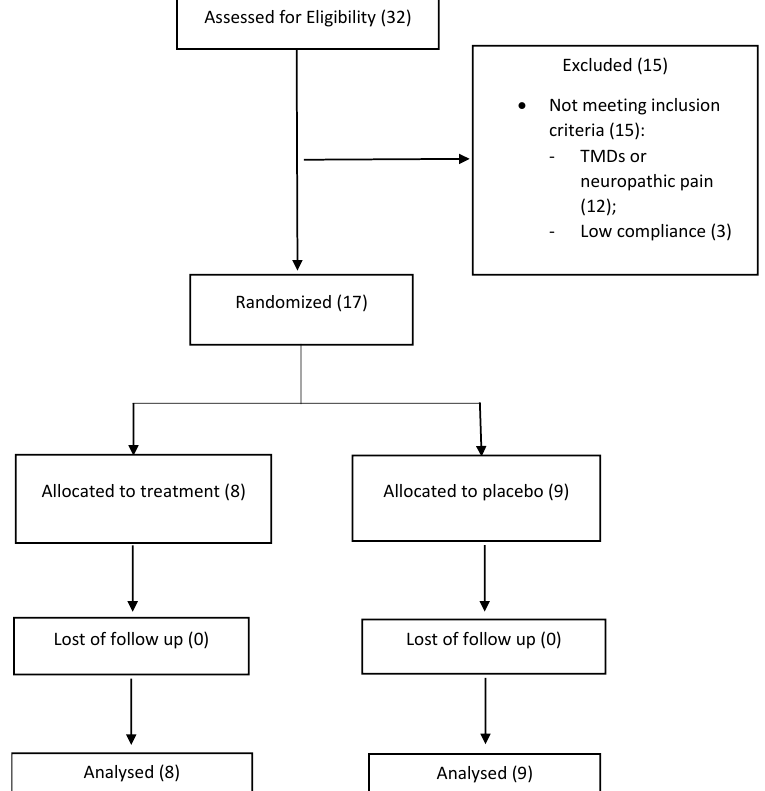
Figure 1. CONSORT. The table analyzed the methodological process of patients recruitment for the randomized controlled trial.